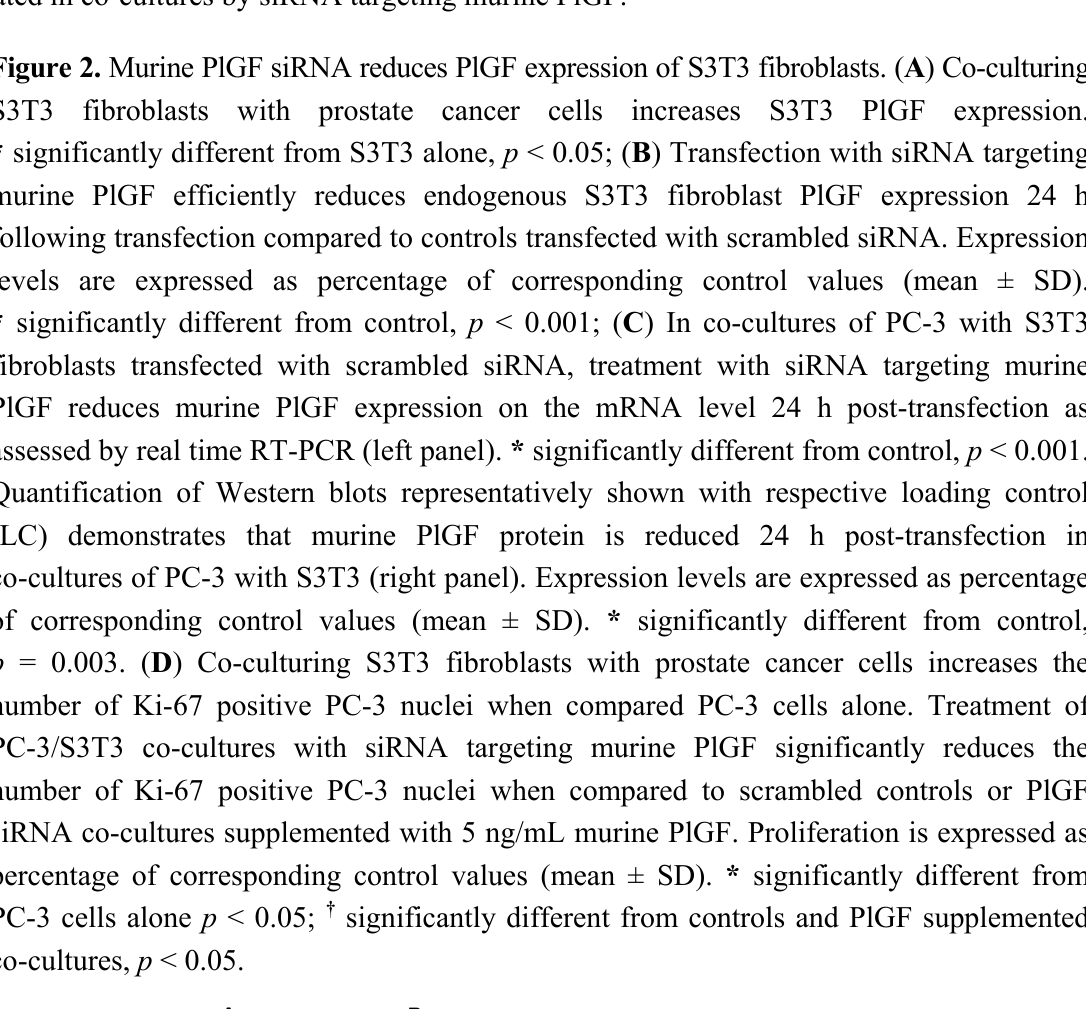
Figure 2. Murine PlGF siRNA reduces PlGF expression of S3T3 fibroblasts. ( A ) Co-culturing